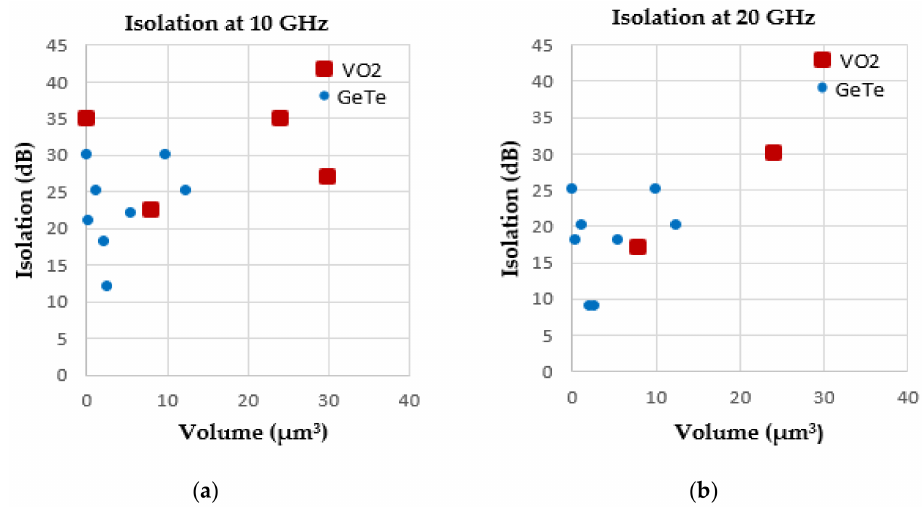
Figure 18. Isolation associated with each reported volume of the device. ( a ) Isolation at 10 GHz; ( b ) Isolation at 20 GHz.